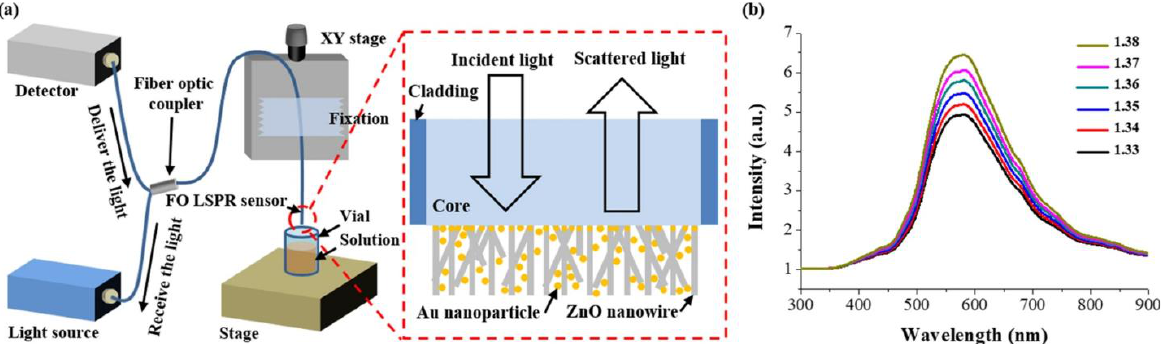
Figure 3. Schematic of the optical system and the LSPR spectra measured using the sensor proposed in Kim et al. [47]: ( a ) Measurement set-up based on the optical fiber and ( b ) spectra measured using 3D FO-LSPR sensor for solutions of different refractive indices. The figure in Kim et al. [47] is reprinted with permission from Nature publishing Group (NPG).